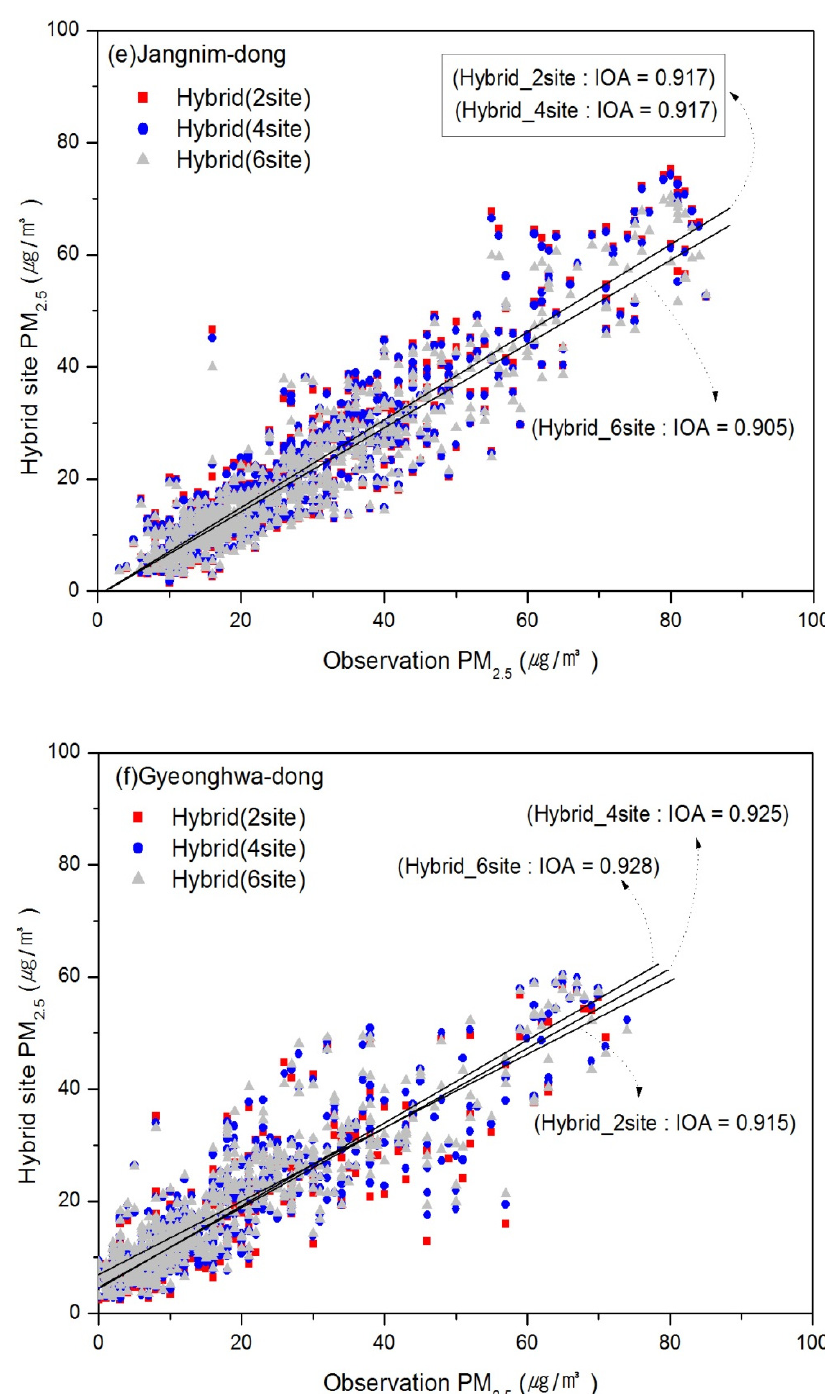
Figure 10. Scatter plot by verification points (prediction result by hybrid model). ( a ) Choryang-dong, ( b ) Gwangbok-dong, ( c ) Gwangan-dong, ( d ) Noksan-dong, ( e ) Jangnim-dong, ( f ) Gyeonghwa-dong.